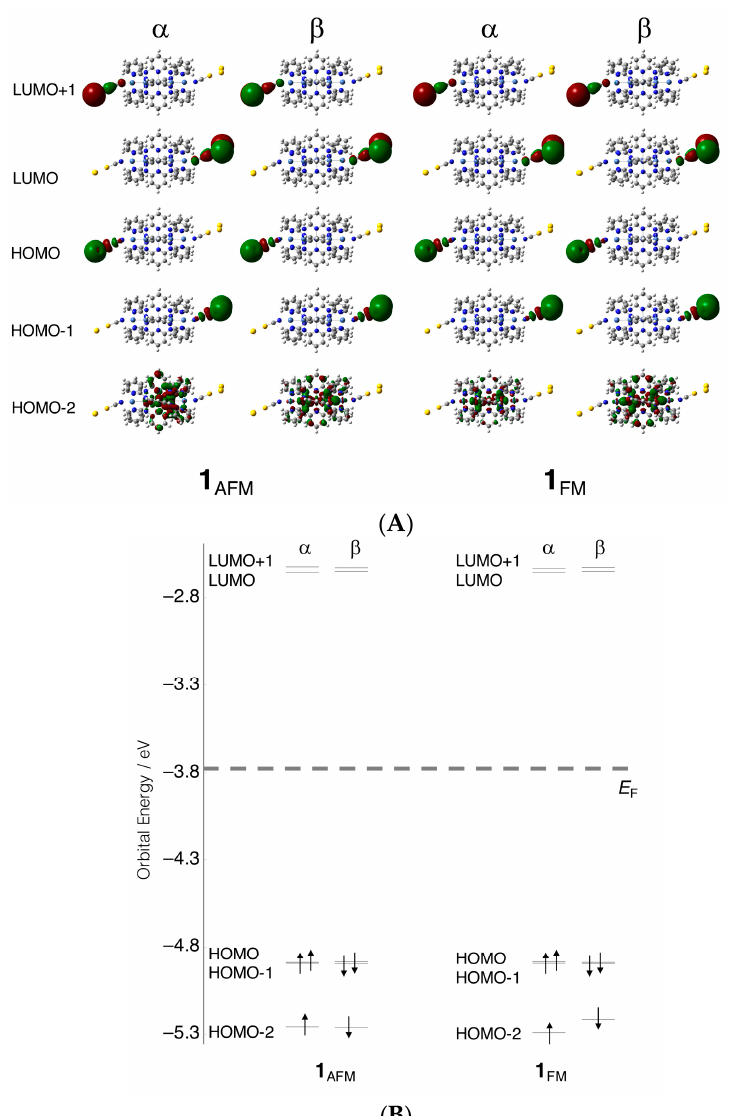
Figure 3. ( A ) Calculated frontier orbitals (highest occupied molecular orbital (HOMO)-2, to lowest unoccupied molecular orbital (LUMO)+1) and ( B ) their energies of 1 AFM and 1 FM .